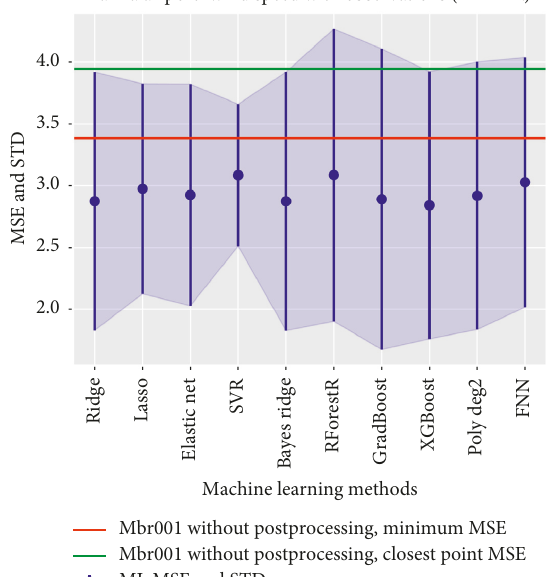
Figure 14: 10meters total wind calibration plot for Palma airport. Horizontal axis as in Figure